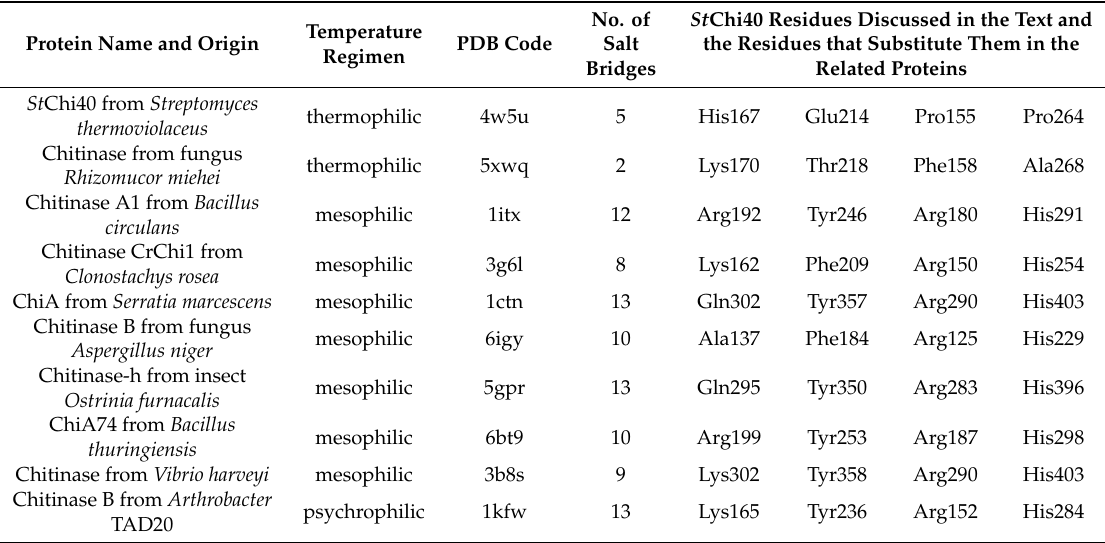
Table 1. Number of salt bridges and a comparison of residues in related